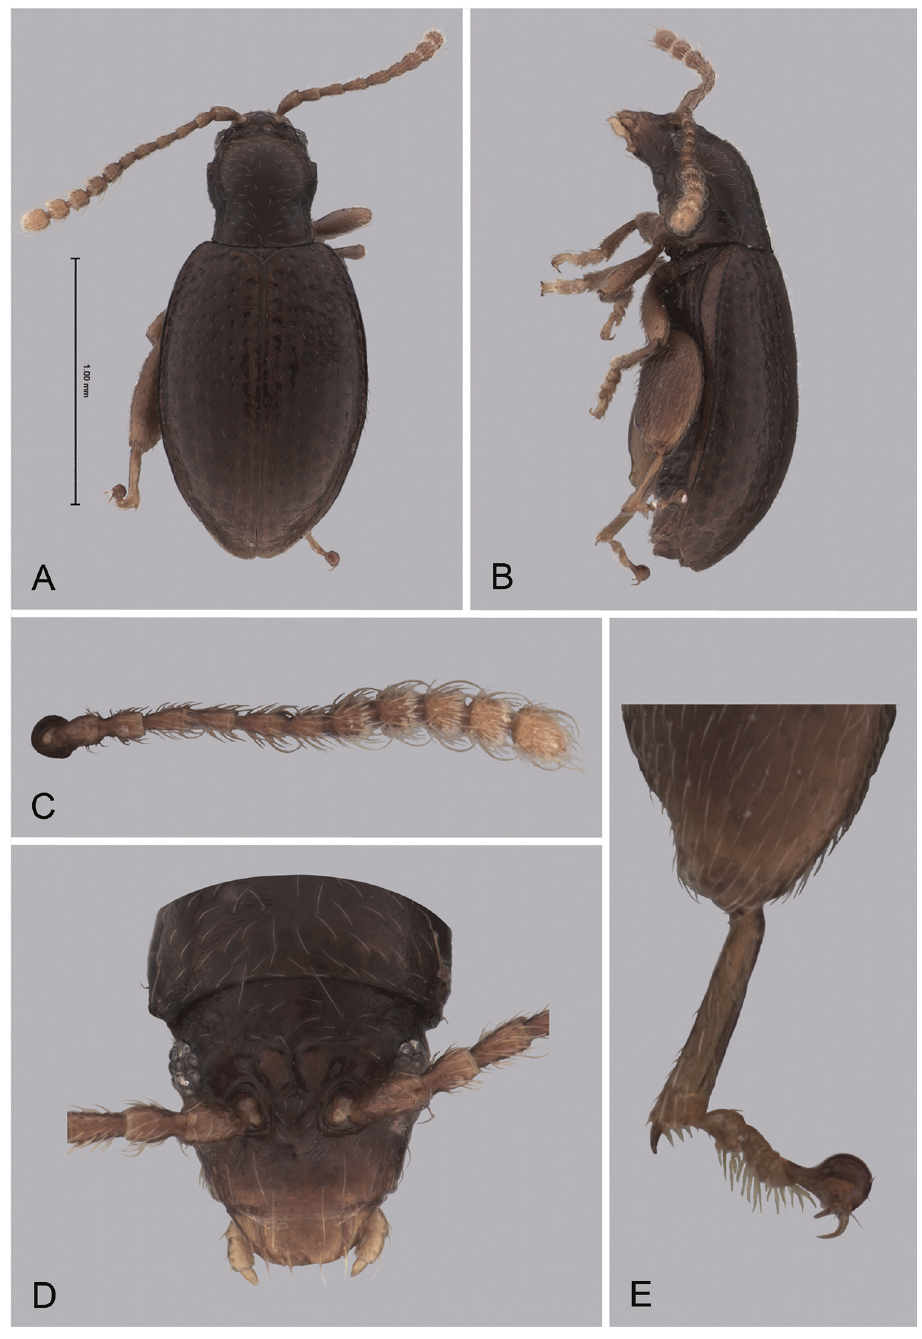
Figure 23. Andersonoplatus microoculus . A Habitus dorsal B Habitus lateral C Antenna D Head, frontal view E Hind